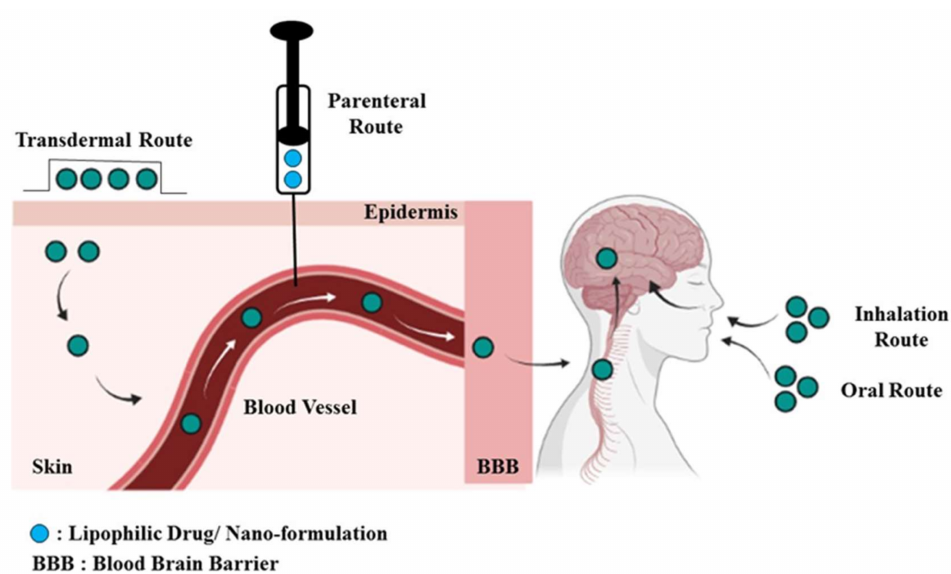
Figure 4. Different routes of administration through which drug reaches to brain by crossing BBB.